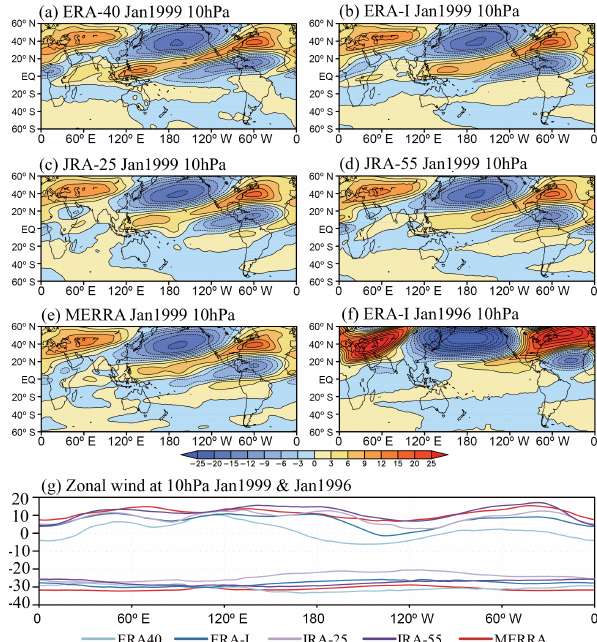
Figure 10. Deviation of the zonal wind values from the zonal mean ( u (cid:48) ) at 10hPa of (a–e) five reanalyses in January 1999 during the westerly phase and (f) of the ERA-I in January 1996 during the easterly phase of the QBO. The color interval is ± 3, 6, 9, 12, 15, 20, or 25ms − 1 . (g) Longitudinal variations of the zonal wind of each reanalysis at 10hPa over the Equator in January 1999 and Jan- uary